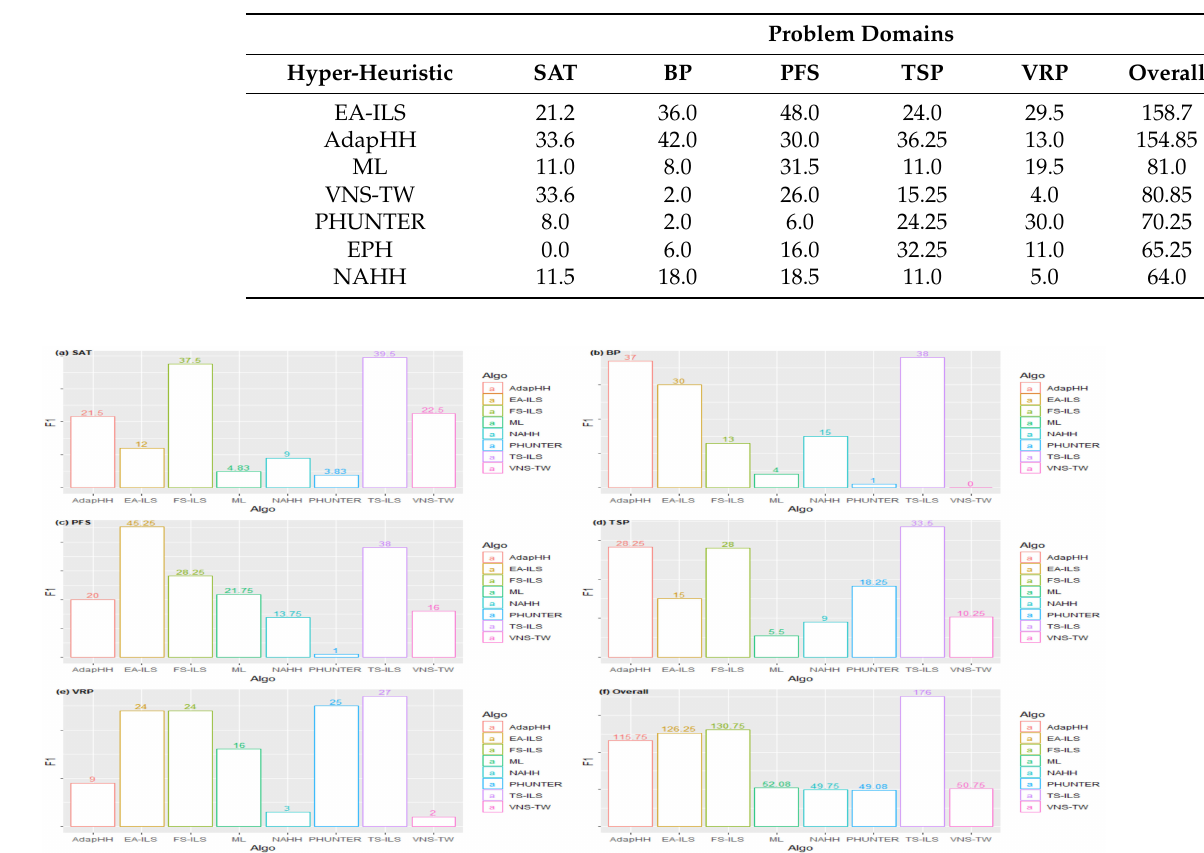
Table 12. F1 scores of top 7 Hyper-heuristics after comparing EA-ILS with the 20 CHeSC entries.